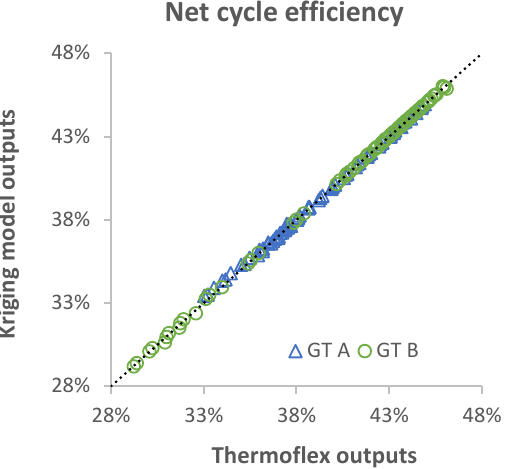
Processes 2018 , 6 , x FOR PEER REVIEW Figure A5. Parity plot of the net cycle efficiency for the off-design model validation.